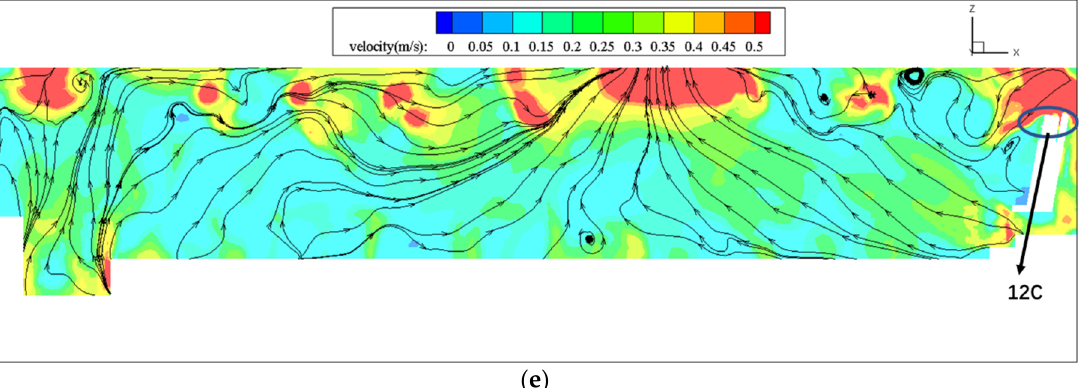
Figure 9. Flow fields on cross section through ( a ) x = 1.2 m, ( b ) x = 4 m, ( c ) x = 8.9 m, longitudinal section through ( d ) y = 0.46 m, ( e ) y = 0 m.